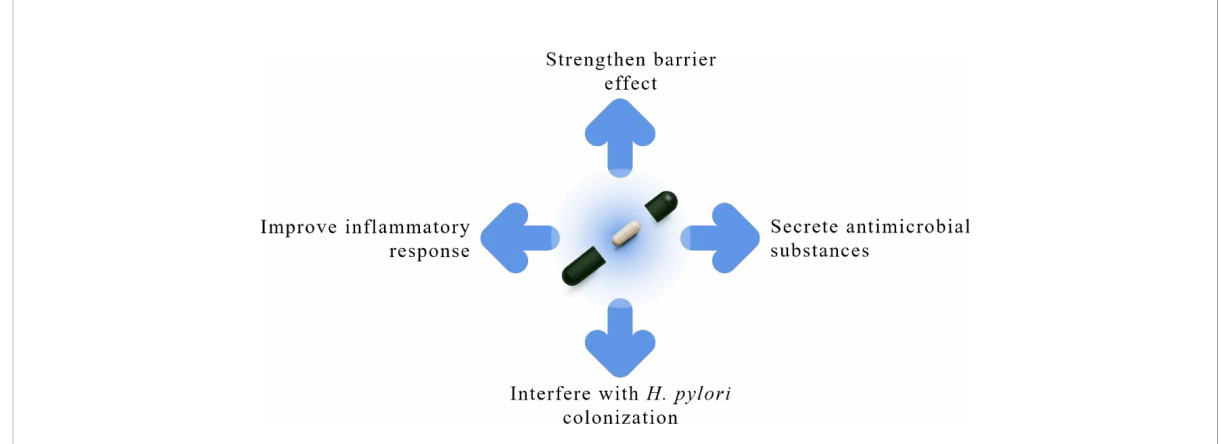
FIGURE 3 A schematic diagram of the potential mechanism of action of probiotics against H. pylori